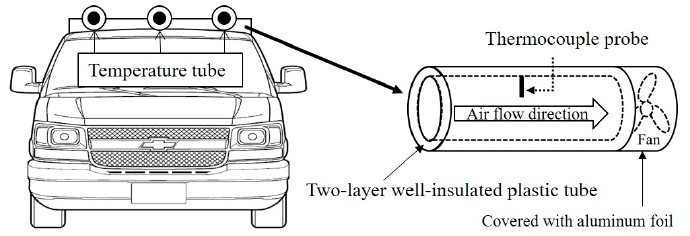
Figure 3. The experiment vehicle with installed sensors.